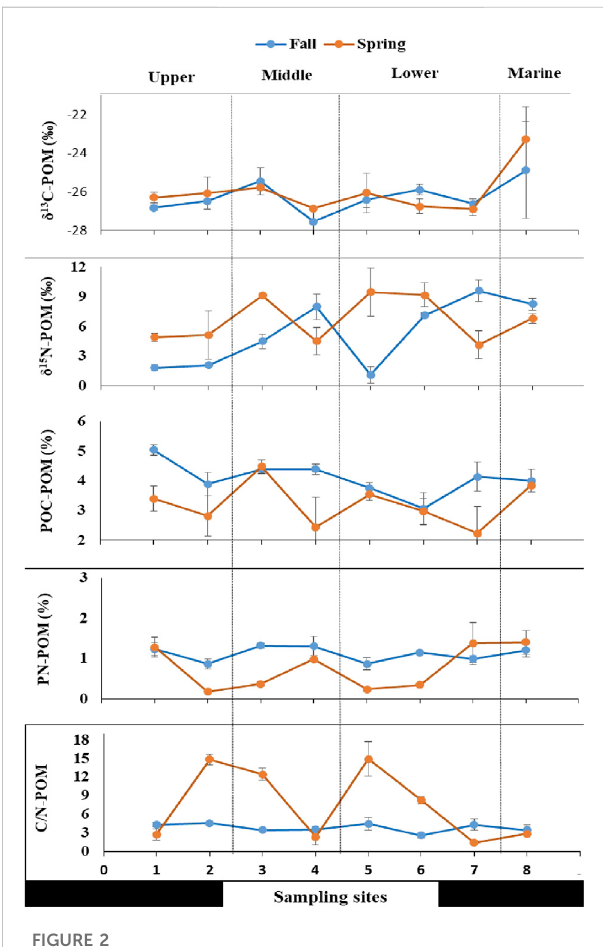
FIGURE 2 Spatiotemporal variation in the elemental and isotopic composition of POM along the Iyidere River. Blue dots represent samples collected in the fall season, and orange dots represent samples collected in the spring season. Error bars indicate standard deviation for each